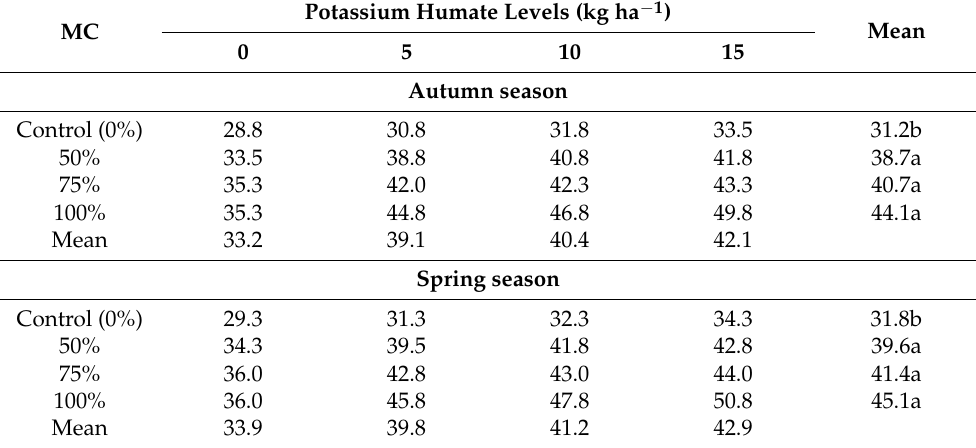
Figure 3. Interaction graphs for harvesting index obtained under K-humate and micronutrients mixture applied in the autumn and spring seasons. Table 5. Zinc concentration (mg kg − 1 ) in tomato fruit is affected by various K-humate and MC levels under field conditions during